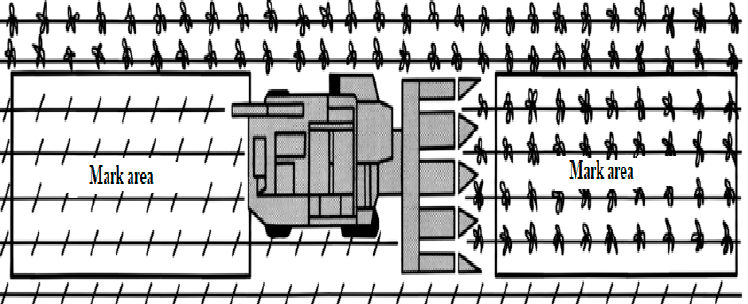
Figure 10. Measurement of ear and header losses from the end and front of the combine [39].